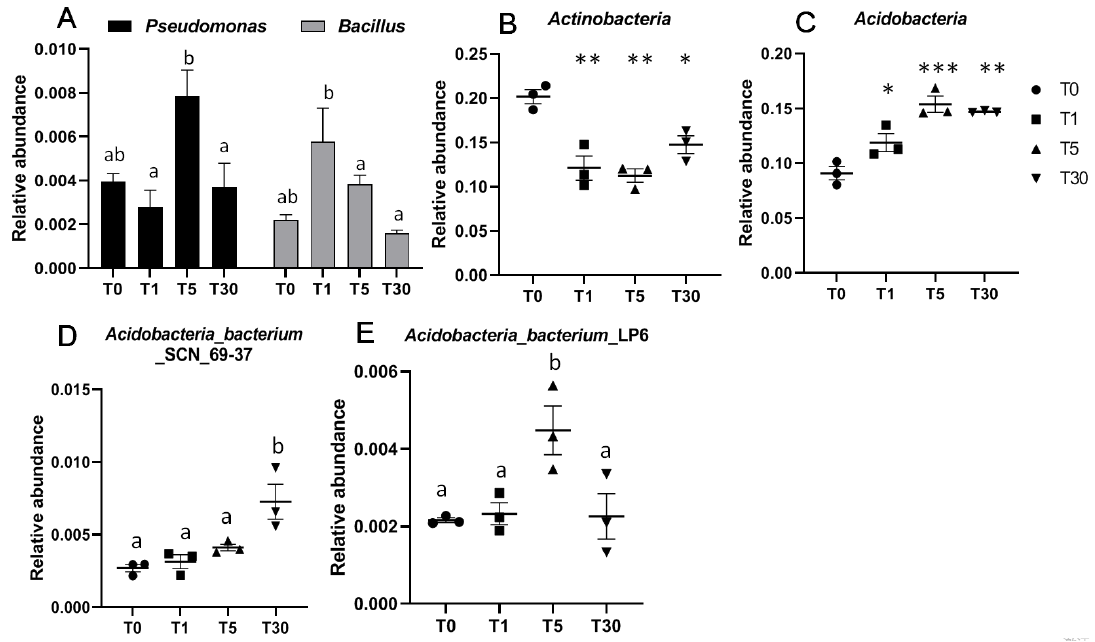
Figure 5. Relative abundance of bacteria in the four di ff erent groups. ( A ) Relative abundance of two beneficial bacteria, including Pseudomonas and Bacillus , were compared for the four groups; ( B ) beneficial bacterial phylum Actinobacteria; ( C ) phylum Acidobacteria; ( D , E ) two Acidobacteria bacteria Acidobacteria_bacterium _SCN_69-37 and Acidobacteria_bacterium _LP6. a and b represent significant di ff erences ( p < 0.05); Significances between di ff erent groups were compared using a one-way ANOVA test, with the results indicated on the top ( p -value ≤ 0.05 = *, p -value ≤ 0.01 = **, and p -value ≤ 0.001 =